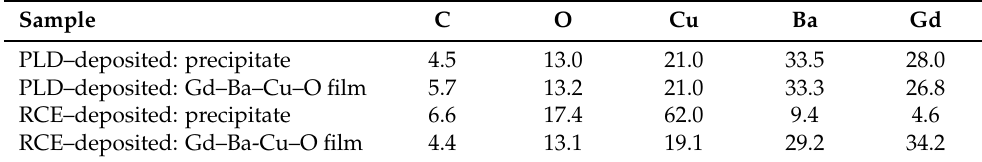
Table 1. Weight concentrations in percentage (%) of elements detected by the EDS method on the surface of PLD-deposited and RCE-deposited samples, at spots indicated in Figure 2. Analysis depth in ∼ 5 µ m range.